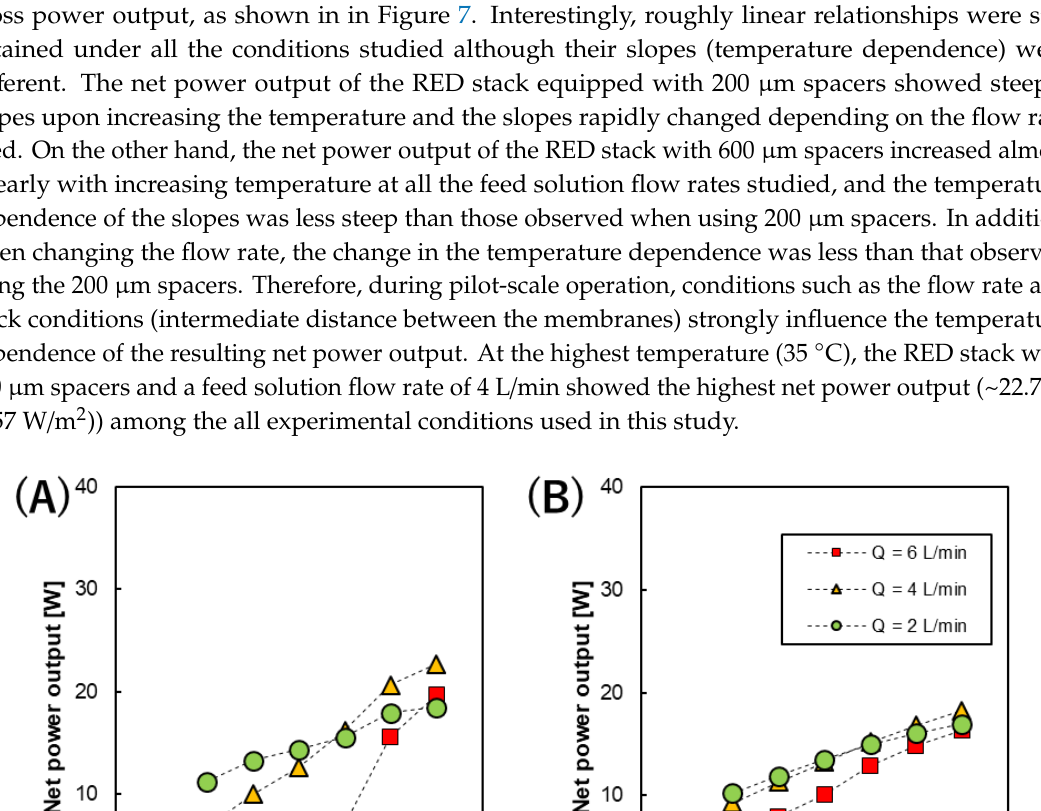
Figure 7 . The temperature dependence of the net power output of the RED stack with an intermediate distance of ( A ) 200 and ( B ) 600 µm at different flow rates.